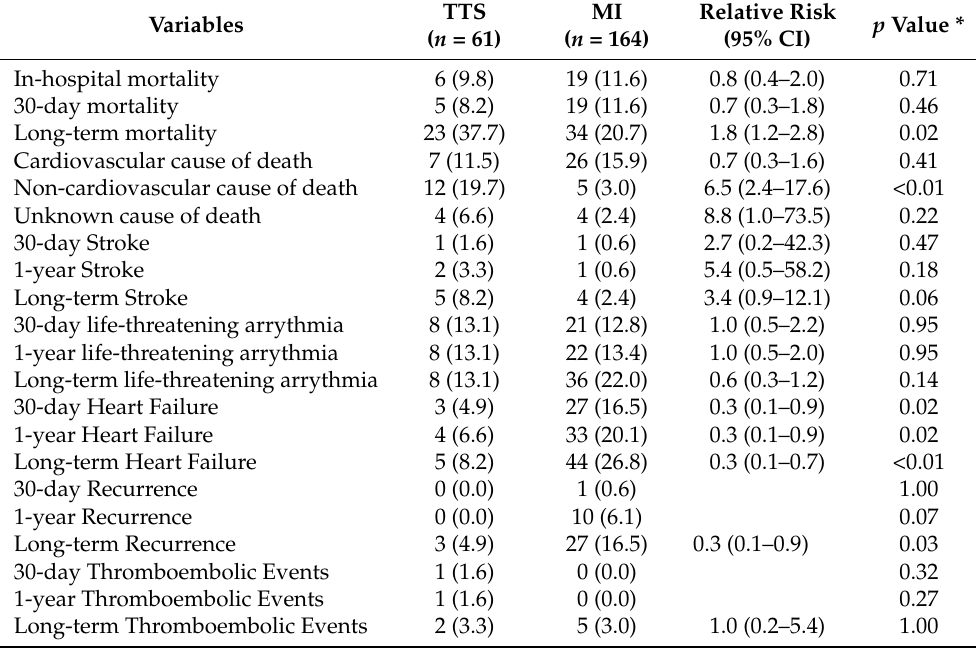
Figure 4. Mortality rate in patients suffering from takotsubo cardiomyopathy (TTS) with and without kidney failure compared to patients suffering MI with and without kidney failure at five-year follow-up. Table 3. Outcomes in 61 TTS patients and 164 MI patients with kidney